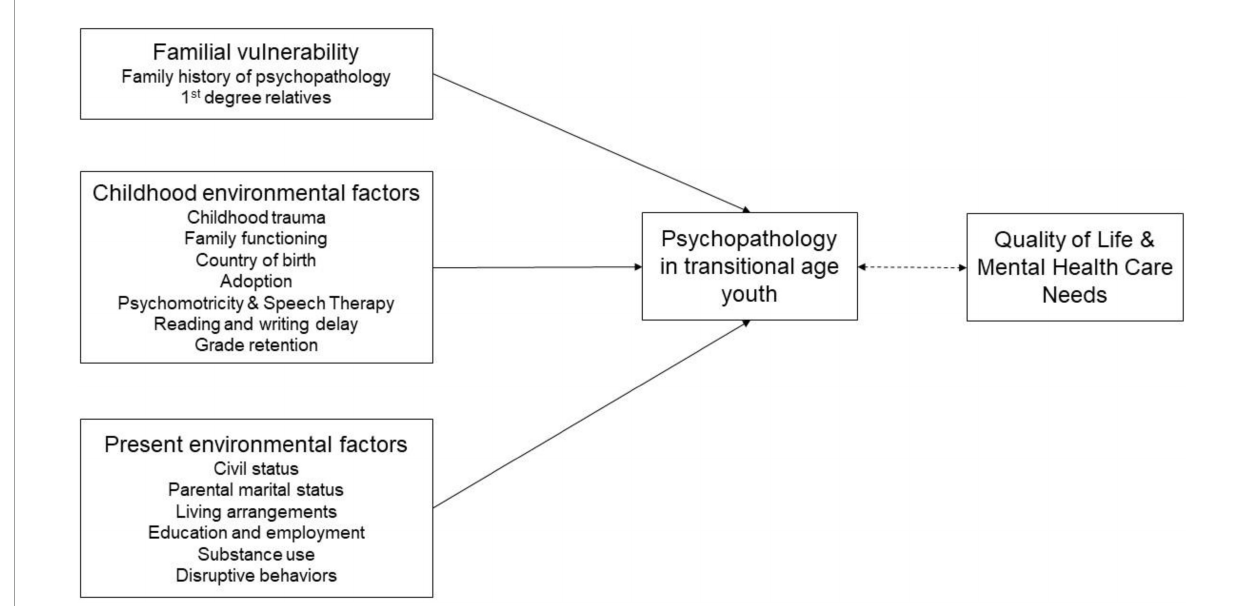
FIGURE1 Conceptual model for the study. The single headed and continuous arrows indicate a predictive relation; the double headed and dotted arrow indicates a correlation.